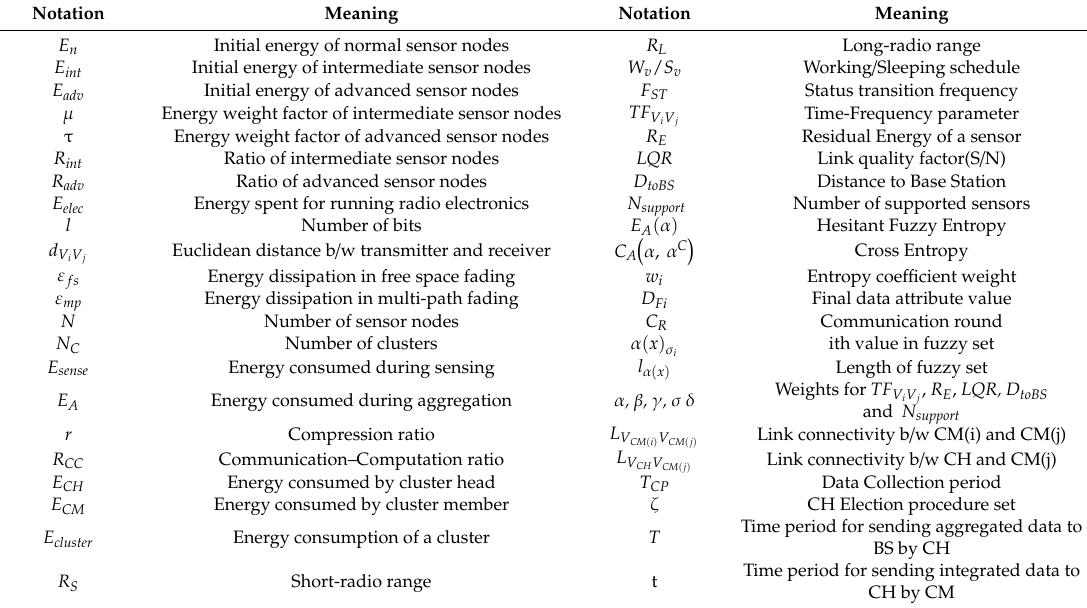
Figure 1. Network Model: heterogeneous wireless sensor networks (WSN) with three types of sensor nodes. Table 1. Notation description.